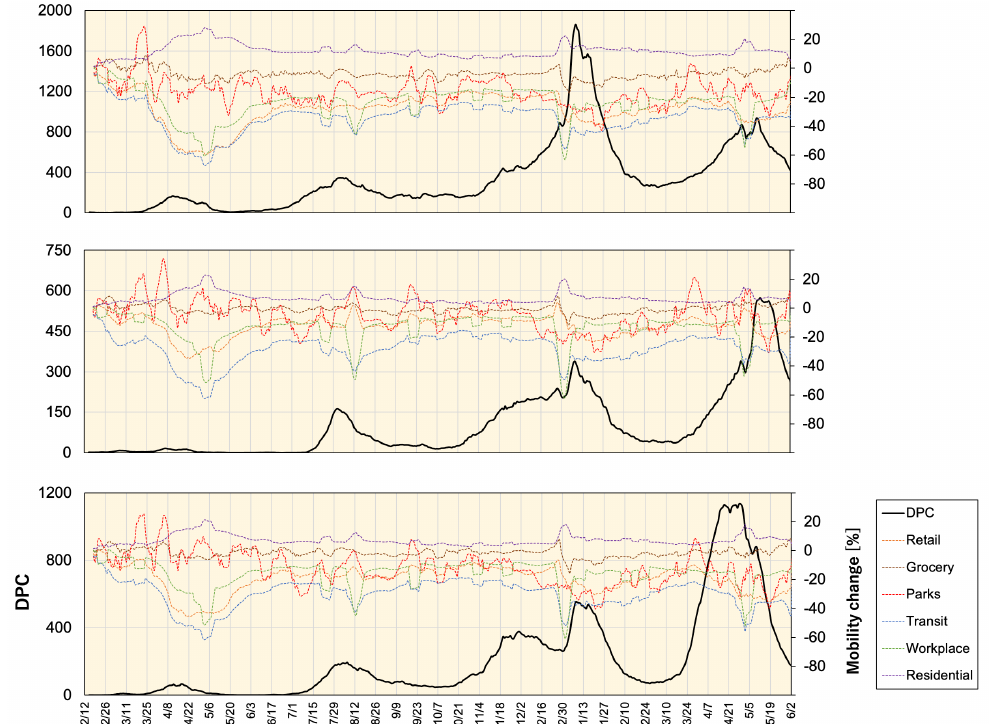
Figure 1. COVID-19 daily positive cases (DPC) and Google mobility change rates from baselines for Tokyo, Aichi, and Osaka (from top to bottom) from 19 February 2020 to 2 June 2021. Lines represent a 7-day